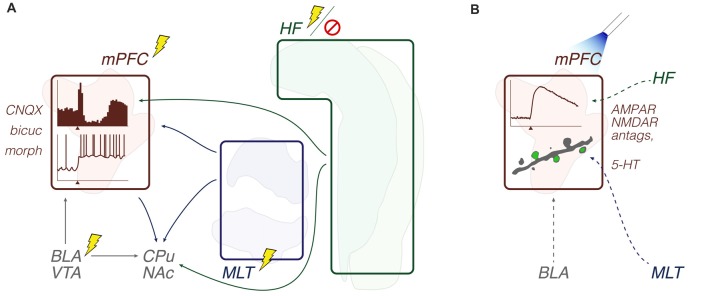
Input convergence: methods and objects of study merged into a schematic summary. The figure portrays generic representations of techniques reviewed in the “Input convergence” subsection. Arrows from the HF are generically positioned, i.e., no distinction is made between dorsal, intermediate and ventral domains. Outlines of brain areas are based on Figure 1. (A)
In vivo electrophysiology, intracerebral electrical stimulation and pharmacological manipulations. Experiments evaluated the prefrontal and striatal concentration of inputs through recording evoked responses upon afferent electrical stimuli, including during drug effects. Lightning and forbidden sign icons represent electrical pulses and hippocampal lesion, respectively. Representative prefrontal cortical data: perievent rate histogram (top) and single-cell voltage trace (bottom) with x-axis arrowheads representing electrical stimuli (e.g., Gigg et al., 1994; Lewis and O’Donnell, 2000). (B)
In vitro electrophysiology, optogenetics and pharmacological manipulations. Experiments evaluated the prefrontal concentration of inputs through recording evoked responses upon optogenetic triggering of glutamate release, including during drug effects. The beam icon represents blue light pulses for stimulation of channelrhodopsin-expressing presynaptic terminals (dashed arrows). Representative prefrontal cortical data: perievent current trace, and two-photon microscopy of a dendrite (gray) with evoked Ca2+ signals (green; Little and Carter, 2012). Abbreviations: antags, antagonists; bicuc, bicuculline; BLA, basolateral amygdala; CPu, caudate-putamen; HF, hippocampal formation; MLT, midline/paramidline thalamus; morph, morphine; mPFC, medial prefrontal cortex; VTA, ventral tegmental area.